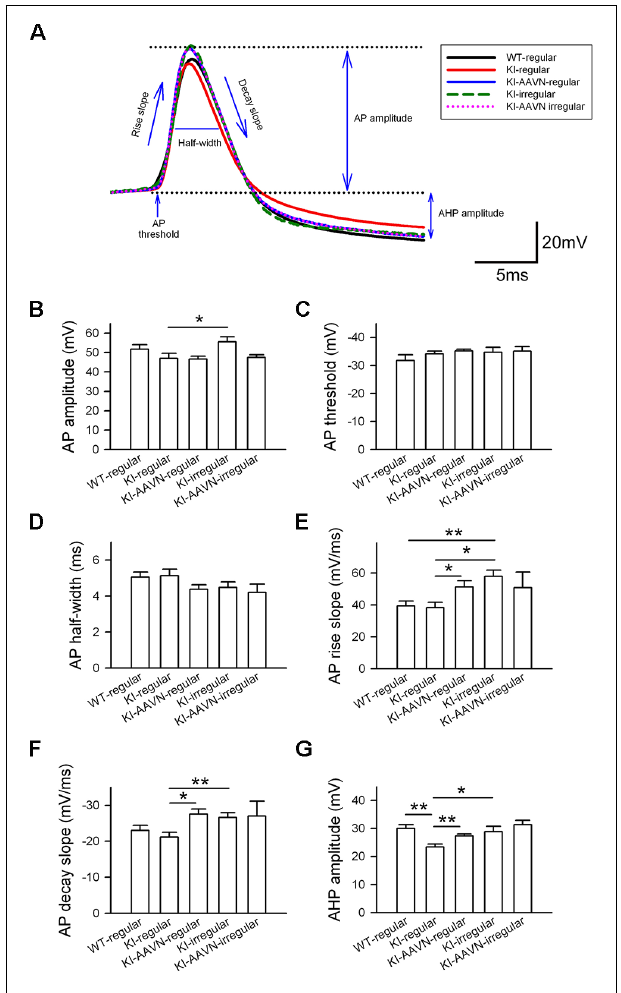
FIGURE 4 | Action potential (AP) properties of SNc DA neurons in WT, KI, and KI-AAVN mice. (A) Overlay comparison of APs in WT mice and KI mice. (B–G) The APs of regularly firing neurons in KI mice exhibited a smaller after-hyperpolarization (AHP) than WI mice ( p < 0.01), and the gene therapy with AAVN-AADC corrected this abnormality. The gene therapy with AAVN-AADC also lead to an unexpected increment in AP rise slope and AP decay slope in the Ddc KI regularly firing DA neurons. The comparison of regularly APs in WT mice and the APs of the irregularly firing neurons in KI mice. The APs of the irregularly firing neurons in the KI mice exhibited a faster rise ( p < 0.05). Furthermore, the irregular firing neurons from Ddc KI mice have higher APs amplitude, rise slope, decay slope and AHP than regular firing neurons. Data were collected from five mice in the WT group, six mice in the KI group and five mice in the KI-AAVN group. ∗ p < 0.05; ∗∗ p < 0.01. firing neurons from the Ddc KI mice revealed that the APs of the irregularly firing neurons in Ddc KI mice exhibited a faster rise ( t ( 19 ) = − 3.706, p = 0.002, Figure 4E ). We also compared DA neurons with regular and irregular firing from Ddc KI mice. Our results showed that the irregular firing neurons form Ddc KI mice have higher APs amplitude ( t ( 18 ) = − 2.349, p = 0.030), rise slope ( t ( 18 ) = − 3.774, p = 0.001), decay slope ( t ( 18 ) = 3.008, p = 0.008) and AHP ( t ( 18 ) = − 2.310, p = 0.033) than regular firing neurons. However, gene therapy with AAVN-AADC did not correct this